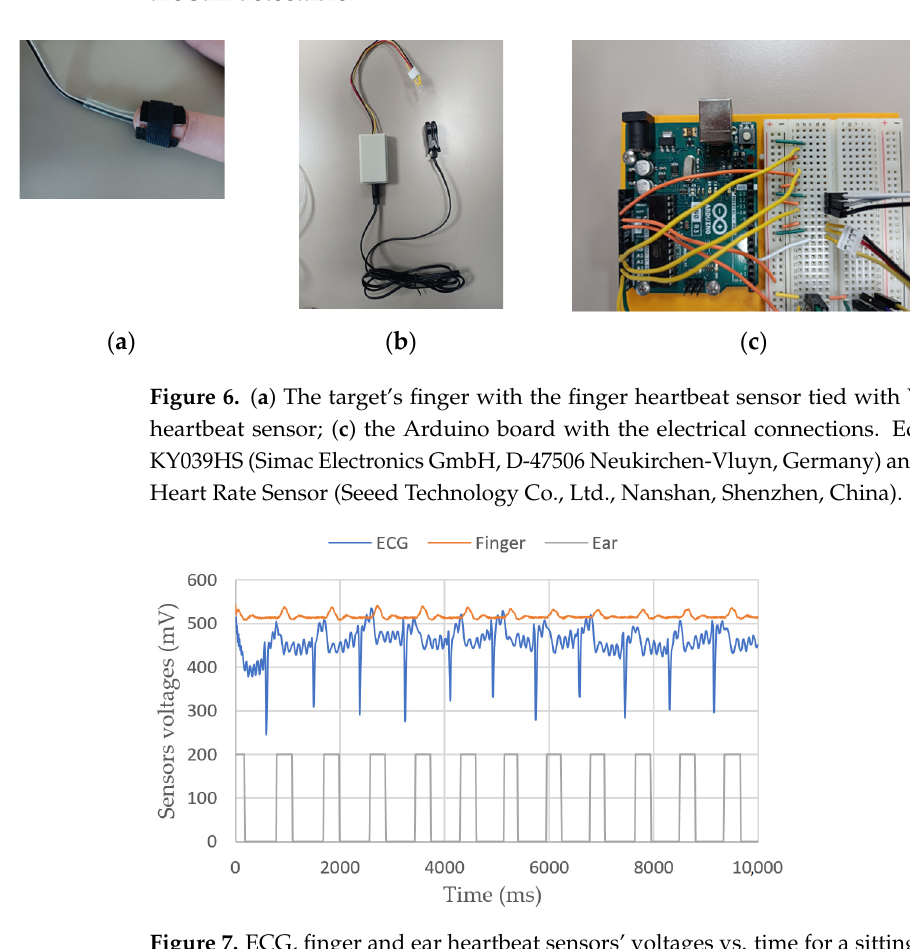
Figure 5. Arduino board with the heartbeat module in blue and 3 electrodes on the right. Equip ‐ ment: DF ‐ Robot Heart Rate Monitor Sensor SKU SEN0213(DFRobot, Pudong, Shanghai, China). 